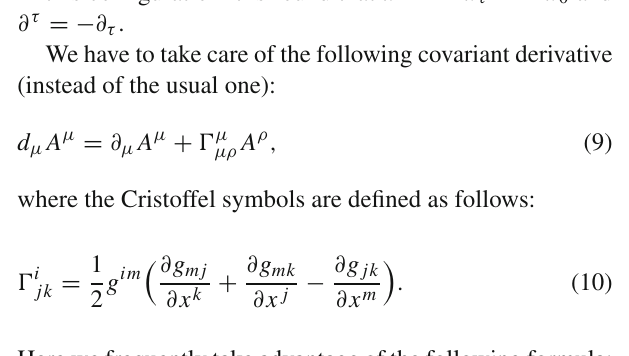
Fig. 1 Transverse MHD u · B =